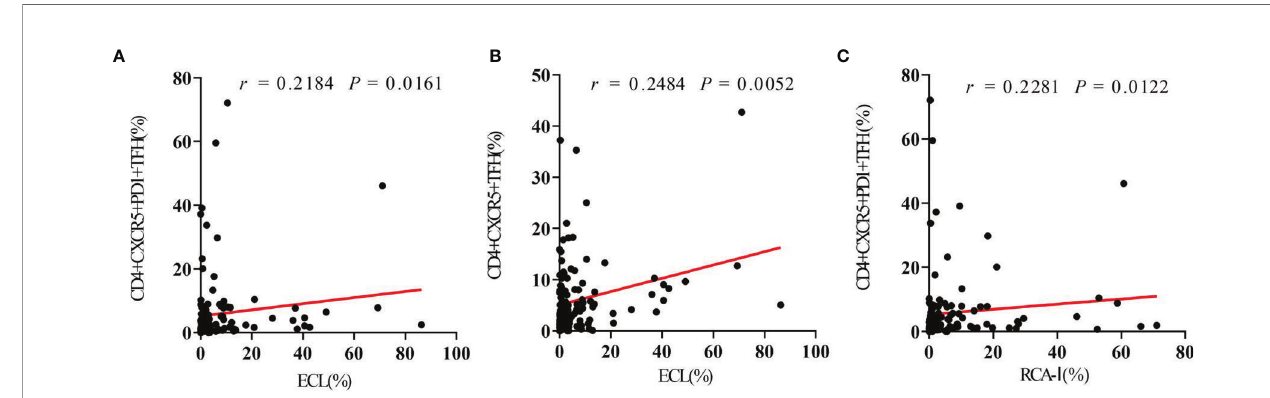
FIGURE 3 | Circulating TFHs positively correlate with platelet desialylation in ITP patients. (A) Correlation between circulating CD4+CXCR5+PD1+ TFHs and ECL binding. (B) Correlation between circulating CD4+CXCR5+ TFHs and RCA-I binding. (C) Correlation between circulating CD4+CXCR5+PD1+ TFHs and RCA-I binding. Spearman ’ s rank correlation coef fi cient (r) and P -value are depicted.